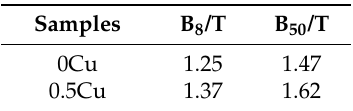
Table 1. The magnetic properties of the sheets (0.3 mm thickness) annealed at 900 ◦ C for 10